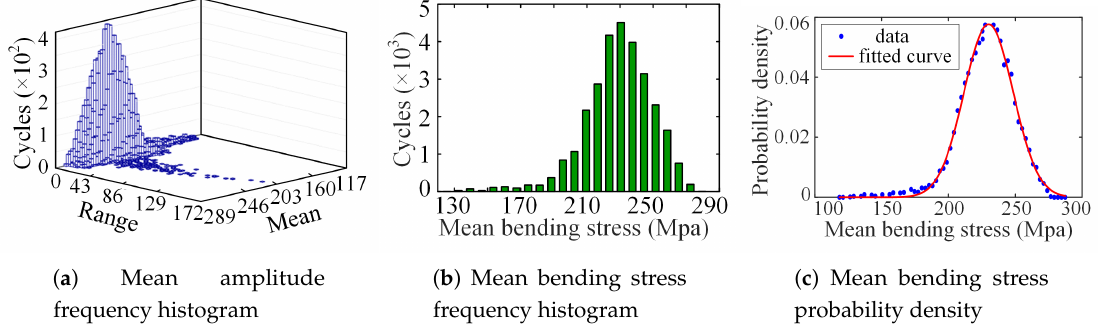
Figure 12. Probability densities of the mean bending stress and the